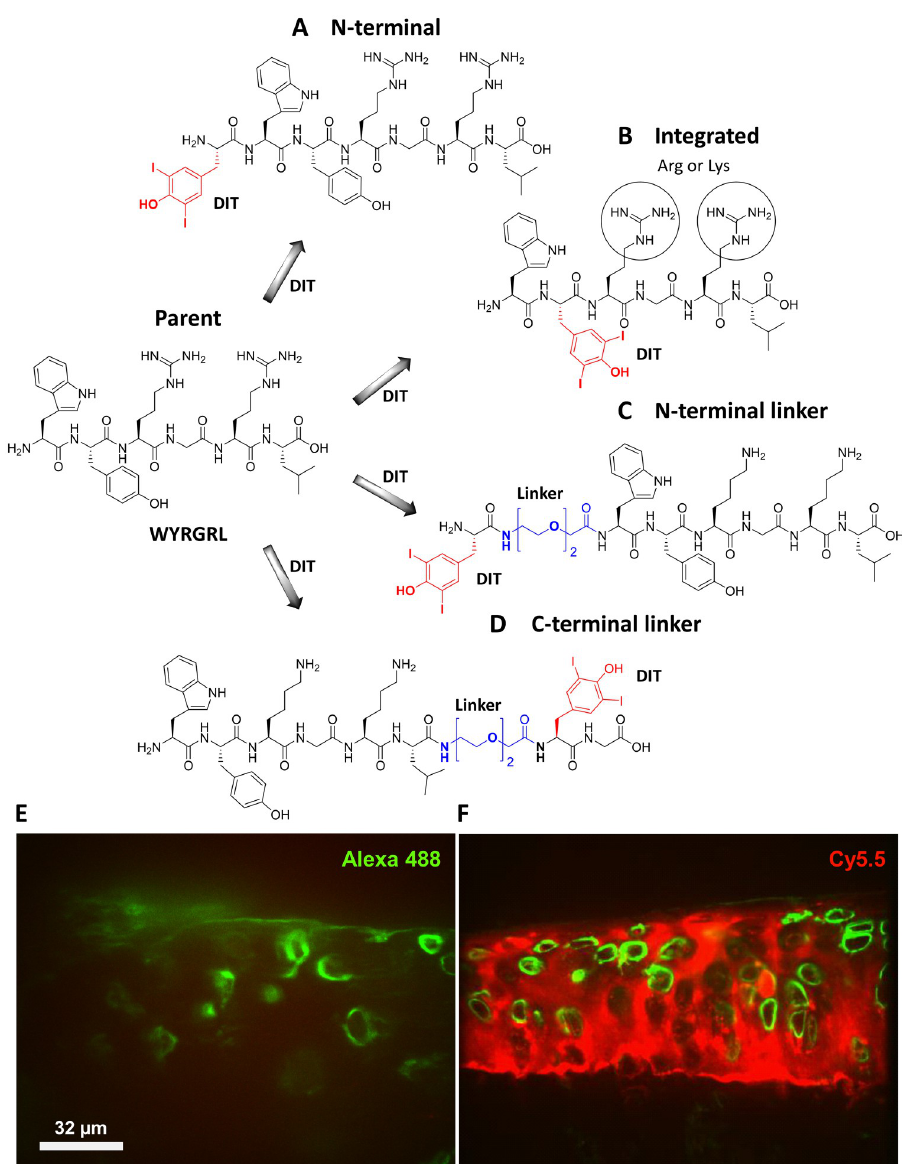
Fig 1. Design of targeted peptide radiocontrast agents through the insertion of DIT into the WYRGRL hexamer. Strategies include N-terminal placement of DIT ( A ), an integrated design ( B ) replacing Tyr with DIT (red) and containing Arg or Lys amino acids (circled), and an N/C-terminal PEG-based linker ( AEEA , blue) approach to separate signalling (DIT) and targeting (WYRGRL) entities ( C , D ). Histology of ex vivo murine articular cartilage 24 h after intra-articular injection of Ac-YRLGRW-DOTAM-Cy5.5 ( E ) or Ac-WYRGRL-DOTAM-Cy5.5 ( F ) into mouse knee joints. Only targeted probe ( F ) showed binding to cartilage (Cy5.5, red) with the pericellular proteoglycan perlecan (Alexa Fluor 488, green) revealing the location of